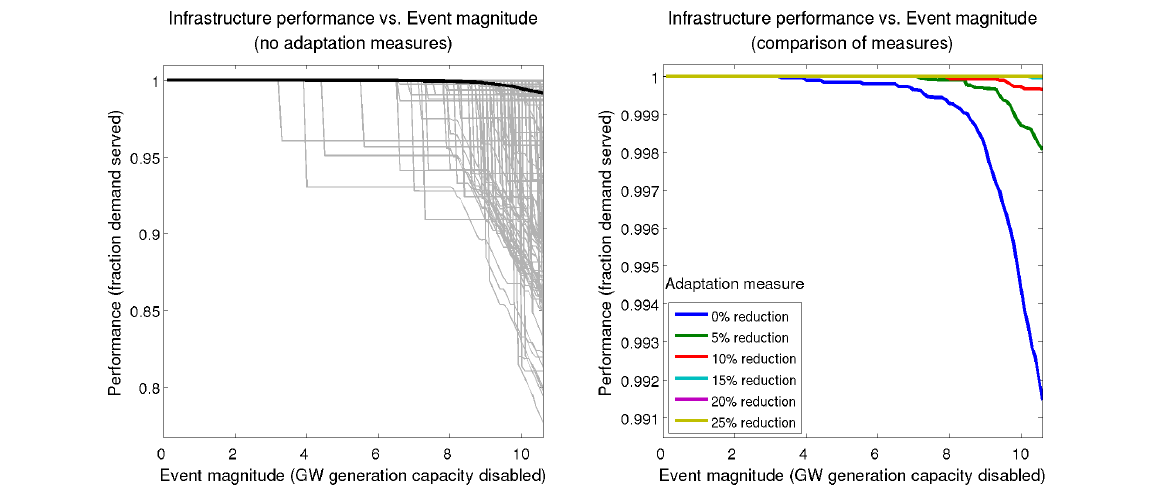
Figure 7. Performance of the modelled infrastructure vs. magnitude of the heat wave event. The left pane illustrates infrastructure performance with no adaptations in place. The right pane compares infrastructure performance with different adaptations implemented. Please be aware of the differing vertical axis scales between the two